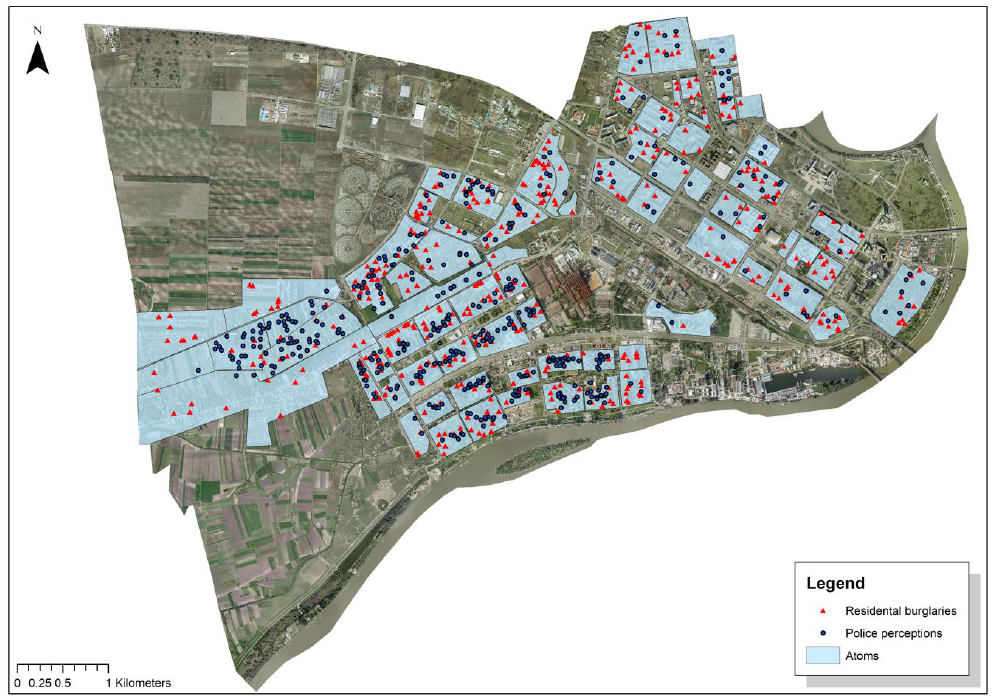
Figure 1. Spatial distribution of atoms with locations of crimes and marked locations (‘perception’) of police officers.